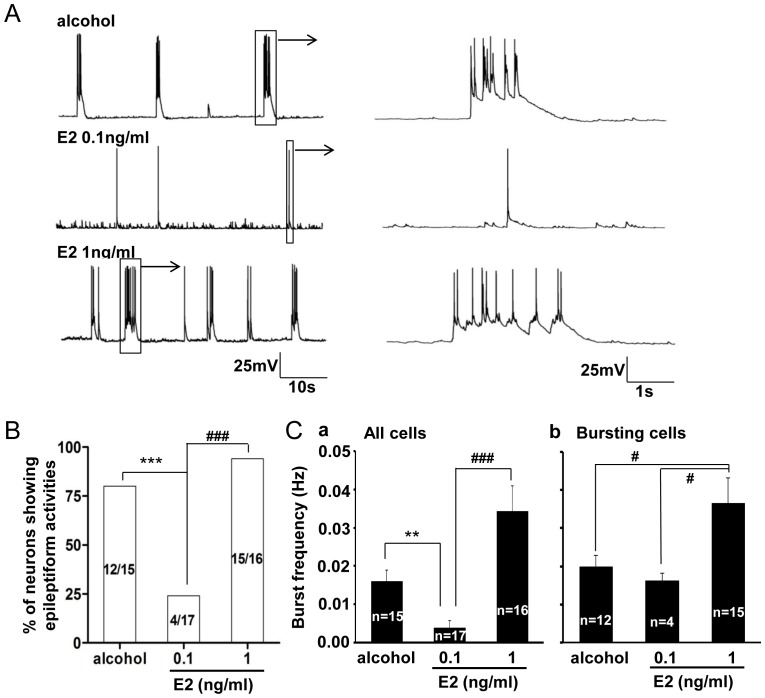
17-β-estradiol dose related inhibition of the epileptiform bursting activities in cultured hippocampal pyramidal neurons.A. Different firing patterns of neurons cultured in medium with either alcohol control or 0.1 and 1 ng/ml 17-β-estradiol. B. Group data showing the dose related suppressive effect of the 17-β-estradiol on the percentage of the neurons having the epileptiform bursting activities. C. Group data analysis showing a significant decrease of the burst frequency by 17-β-estradiol at 0.1 ng/ml pooled either in all tested neurons (P<0.01) (a) or a significant increase of the burst frequency in the estradiol at 1 ng/ml in the bursting neurons (P<0.05) (b). **P<0.01, ***P<0.001; #P<0.05, ###P<0.001.